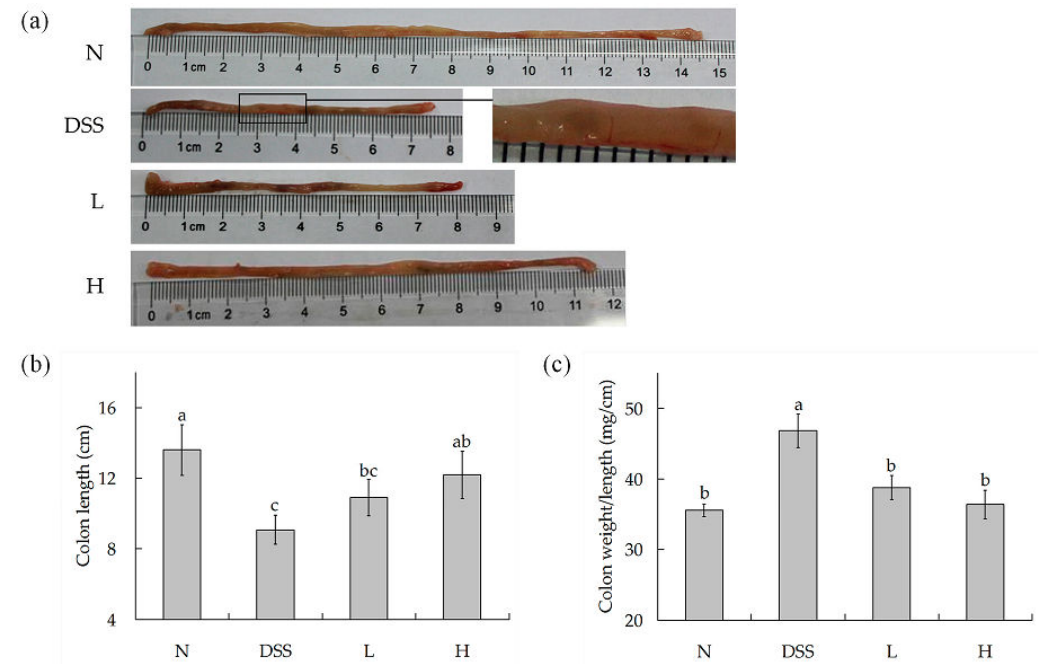
Figure 2. Colon length and weight of colitis mice. ( a ) Morphological observation of colon in mice; ( b ) Colon length in mice; ( c ) Colon weight/length in mice. N (normal group), dextran sulfate sodium (DSS, model group), L (low dose group, 10 9 CFU/kg · bw), H (high dose group, 10 10 CFU/kg · bw); a,b,c expressed as significant level, p <